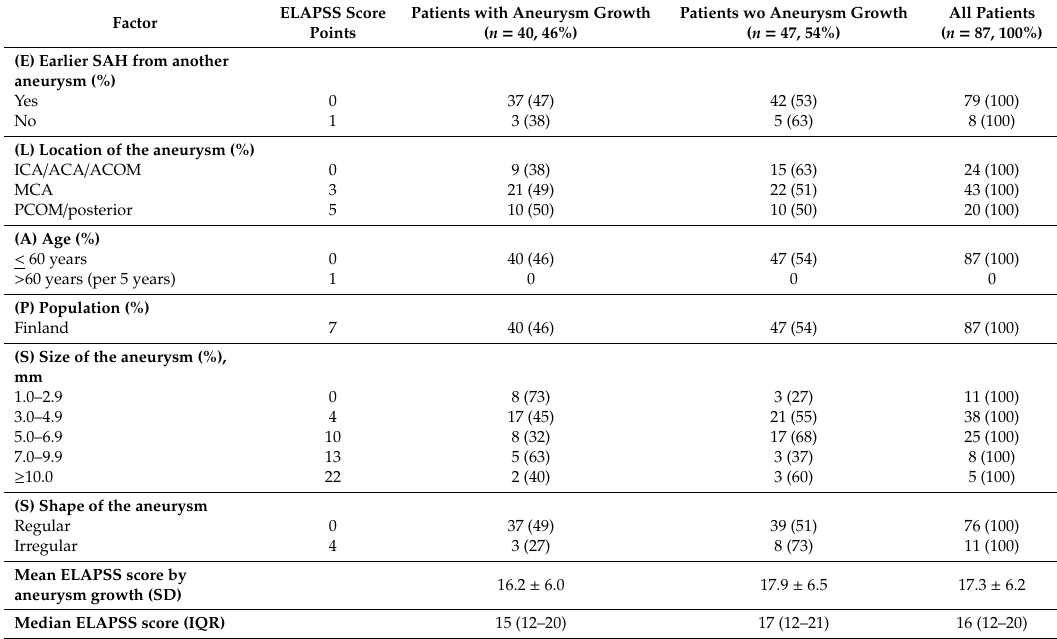
Table 1. ELAPSS score stratified by long-term aneurysm growth. Factor ELAPSS Score